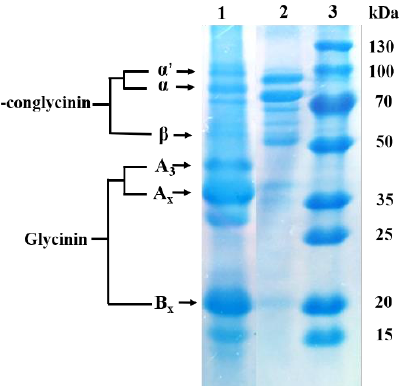
Figure 8. SDS-PAGE diagram of isolated glycinin. Lane 1: glycinin; Lane 2: β -conglycinin; Lane 3: protein marker. Ax and Bx represent acidic and basic subunits of isolated glycinin. α′, α, β stand for subunit fractions of β -conglycinin.